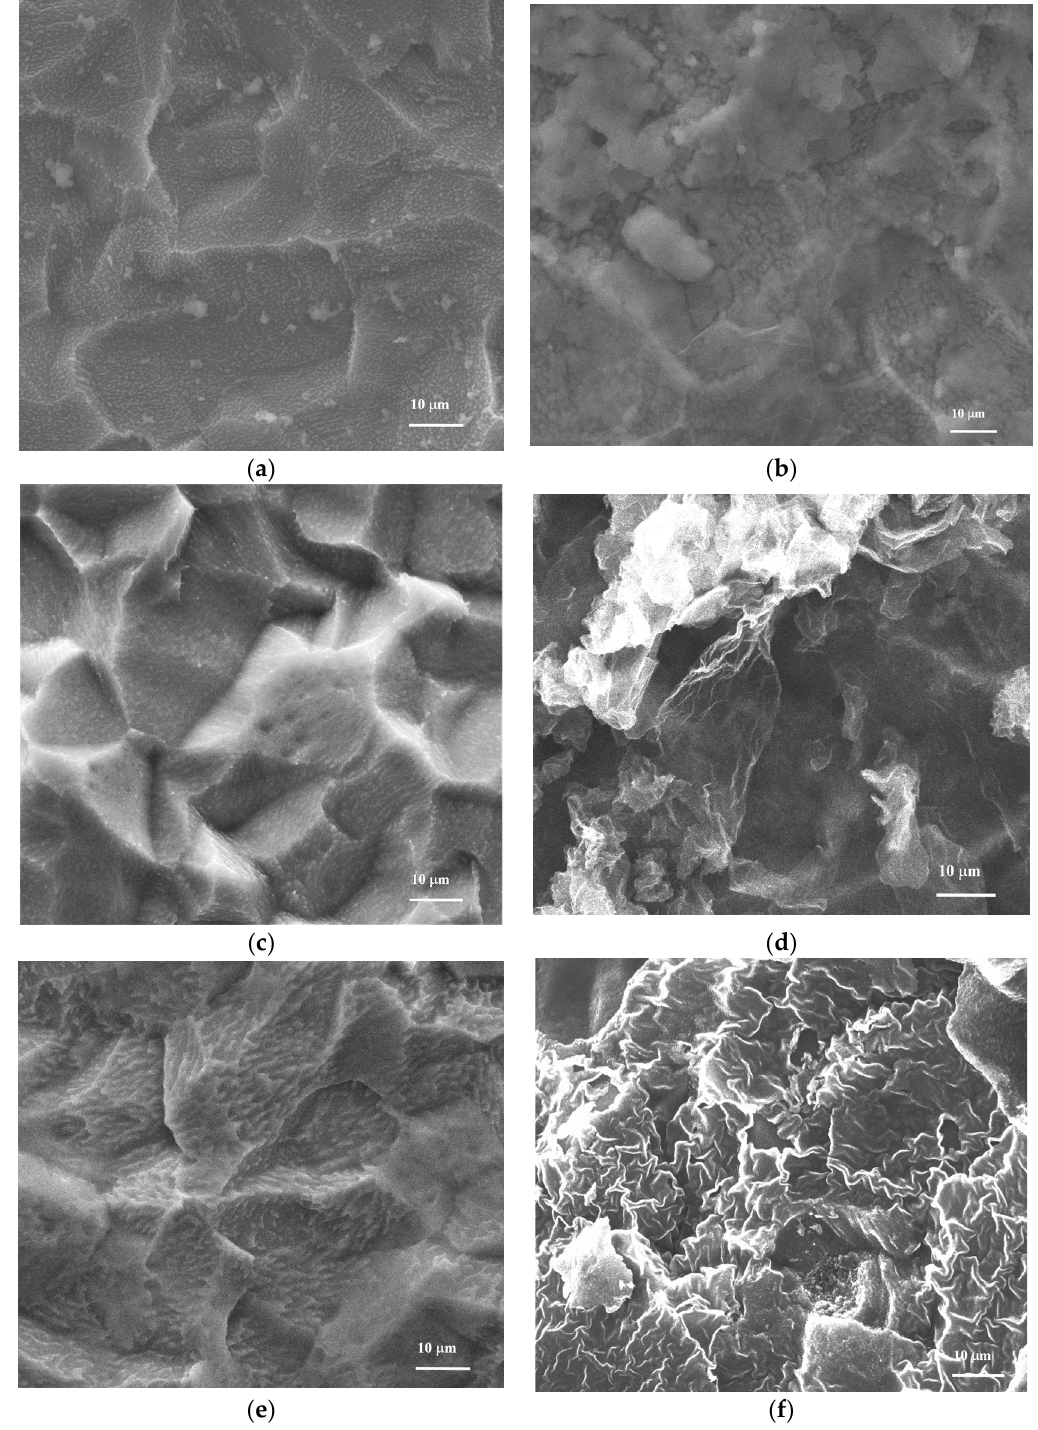
Figure 3. SEM images of ( a ) Ti-TiO 2 -1h, ( b ) Ti-TiO 2 -rGO-1h, (c) Ti-TiO 2 -2h, ( d ) Ti-TiO 2 -rGO-2h, ( e ) Ti-TiO 2 -3h, and ( f ) Ti-TiO 2 -rGO-3h. Ti-TiO 2 -3h, and ( f ) Ti-TiO 2